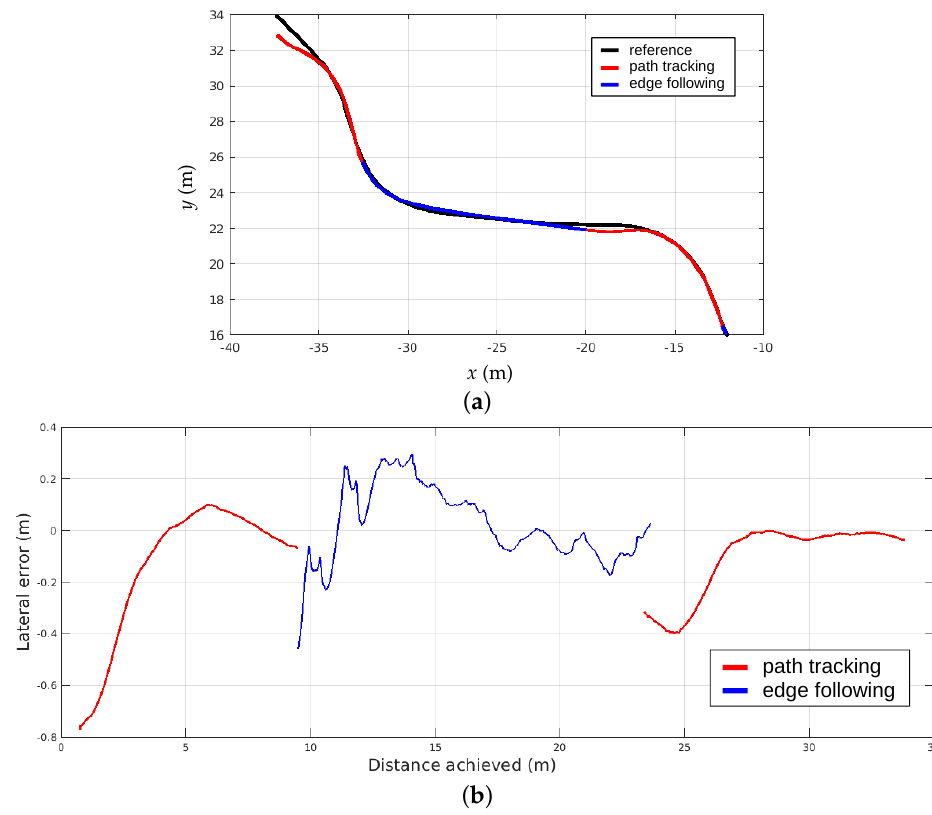
Figure 8. Results of experiment 1. ( a ) Absolute position ( x , y ) of the robot. In red, the robot is in path tracking mode; in blue, it is in edge following mode. The black trajectory corresponds to reference trajectory to follow. ( b ) Lateral error in the Frénet frame of the local trajectory. For path tracking (in red), the local trajectory is the reference trajectory, and for edge following (in blue), it is built from the edge